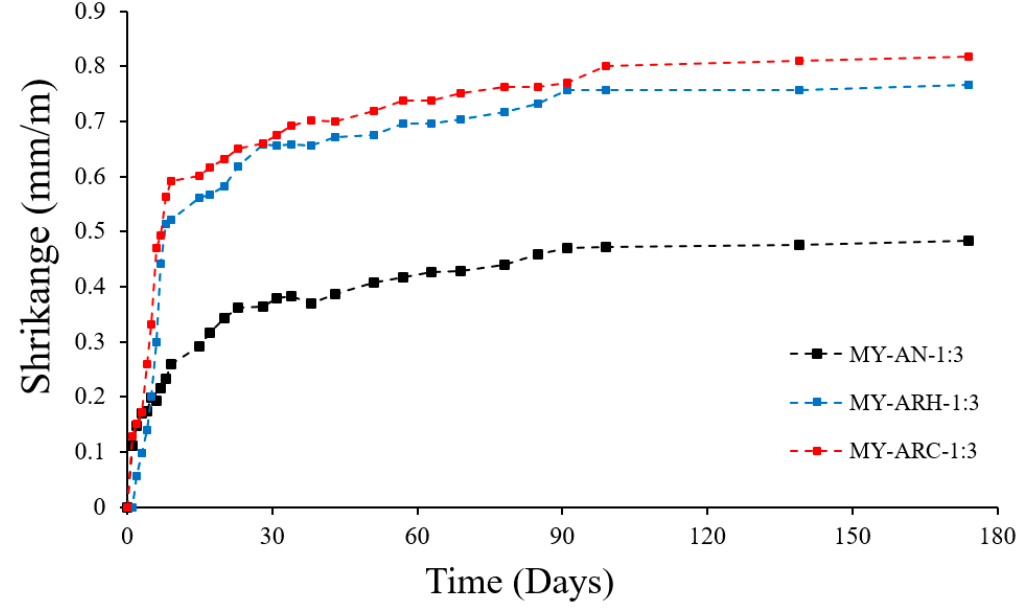
Figure 11. Evolution of shrinkage (mm / m) versus time (days). Cement mortars with a cement / aggregate ratio of 1:3.